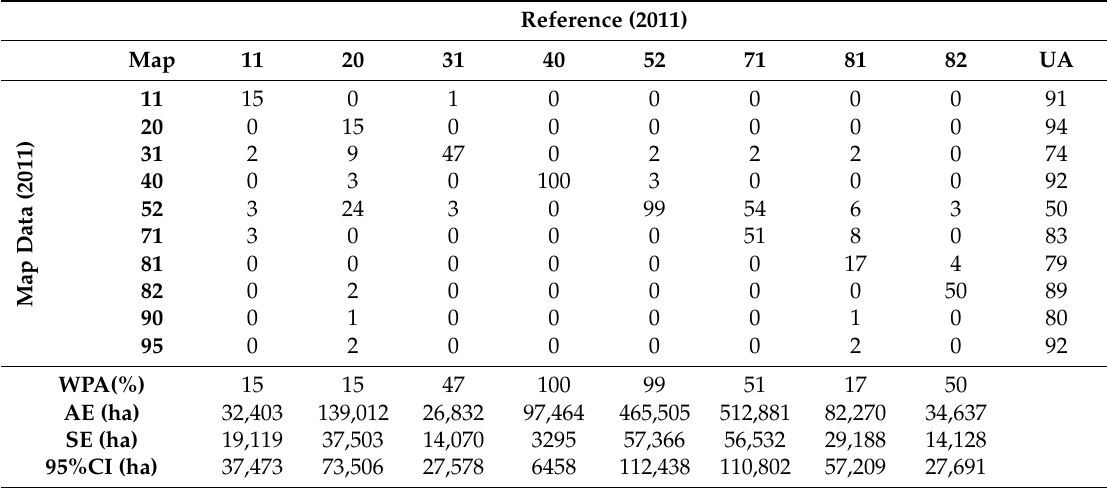
Table A11. Error matrix of San Juan county (2011) expressed by Area Weighted Proportions (%).